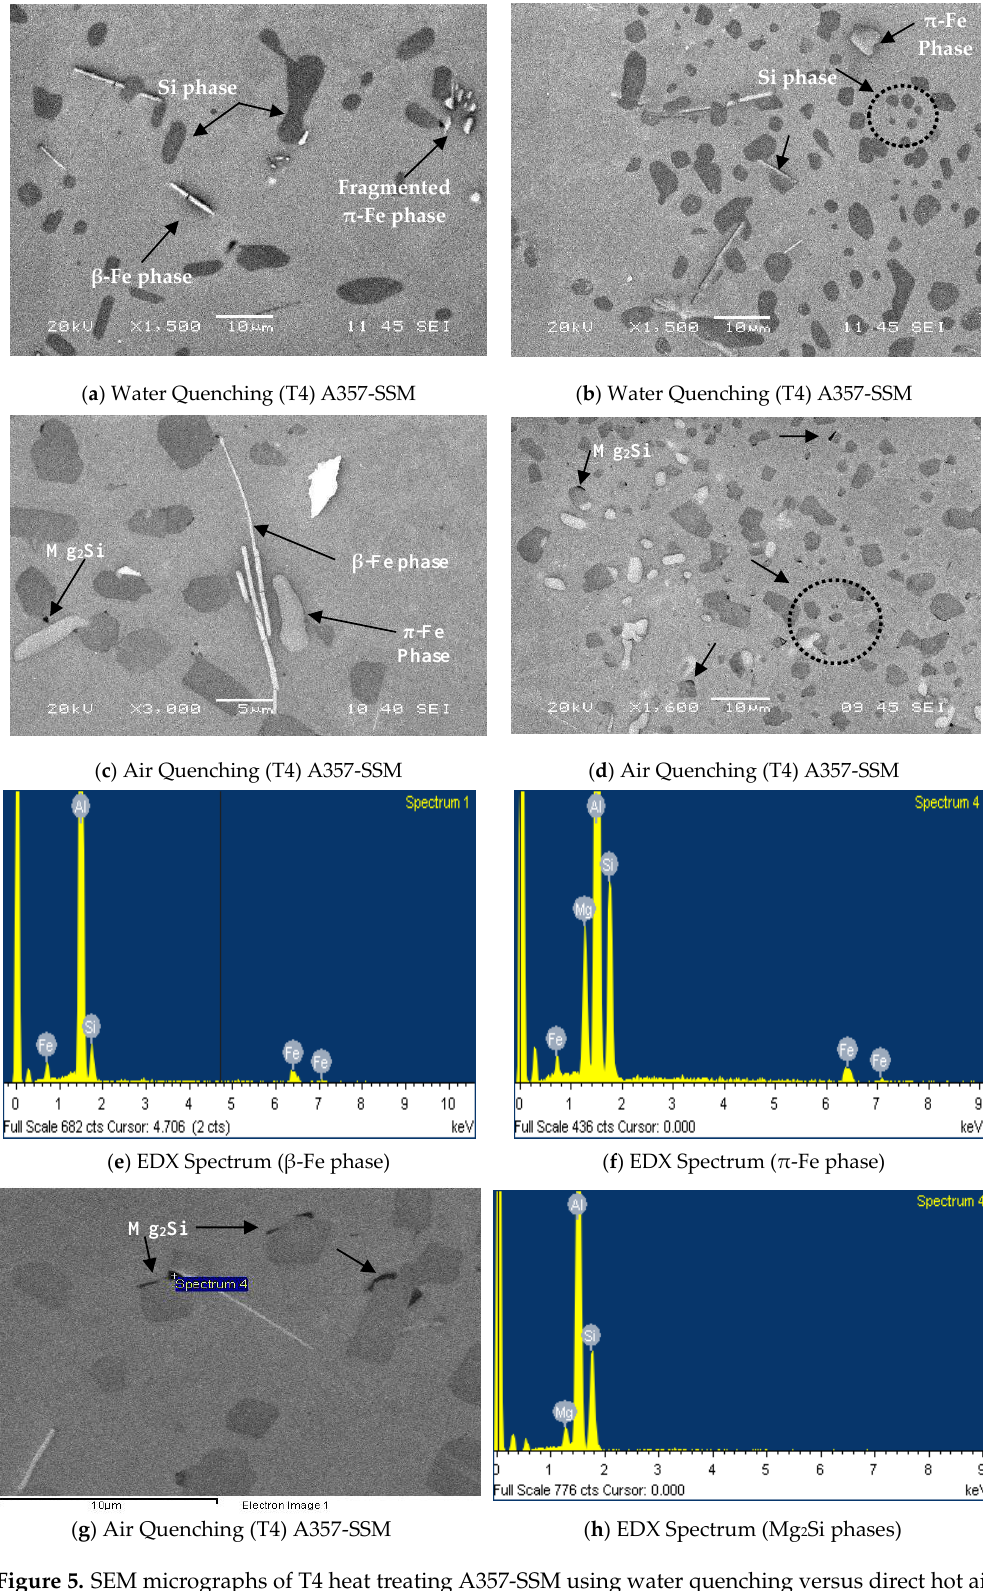
Figure 5. SEM micrographs of T4 heat treating A357-SSM using water quenching versus direct hot air quenching-aging media. ( a ) Water Quenching (T4) A357-SSM, ( b ) Water Quenching (T4) A357-SSM, ( c ) Air Quenching (T4) A357-SSM, ( d ) Air Quenching (T4) A357-SSM, ( e ) EDX Spectrum (β -Fe phase), ( f ) EDX Spectrum (π -Fe phase), ( g ) Air Quenching (T4) A357-SSM, ( h ) EDX Spectrum (Mg 2 Si phases).